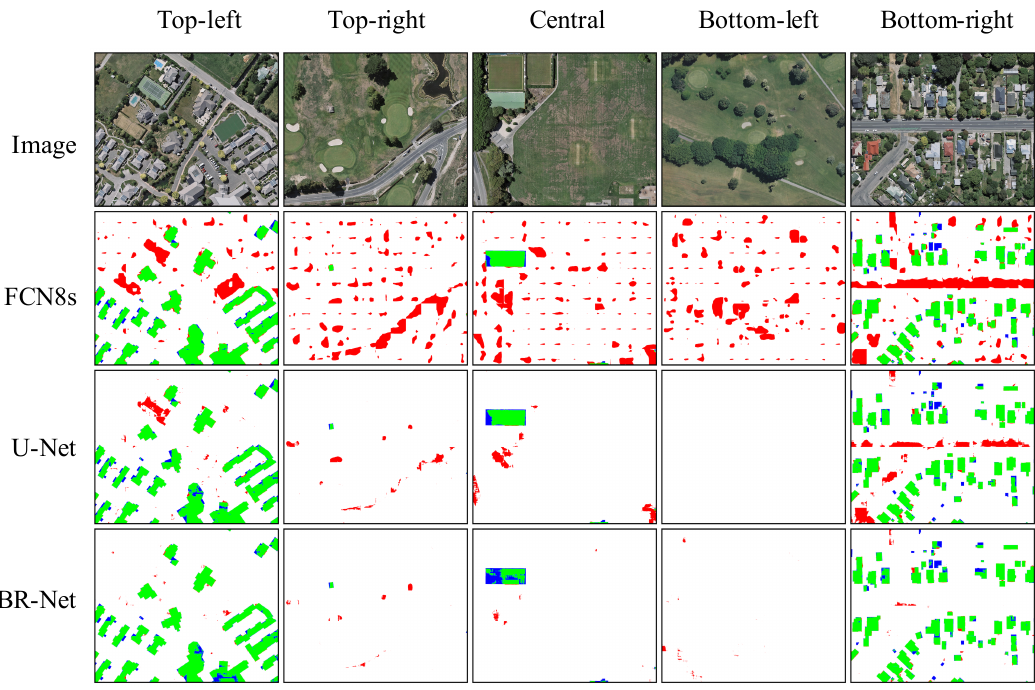
Figure 6. Results of roof segmentation of regions by FCN8s, U-Net, and the proposed BR-Net. The five regions are located in the top-left, top-right, central, bottom-left, and bottom-right portions of the testing area. Each region contains 2240 × 2240 pixels. The green, red, blue, and white channels in the results represent true positive, false positive, false negative, and true negative predictions,